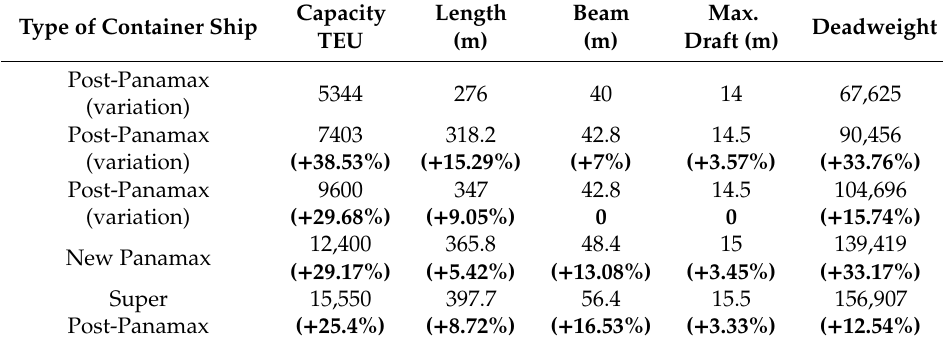
Table 8. Development of basic characteristics of several generations of container vessels. Source: [17]. Type of Container